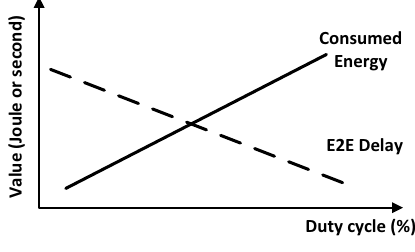
Figure 3: Consumed energy and E2E delay versus duty cycle [15].